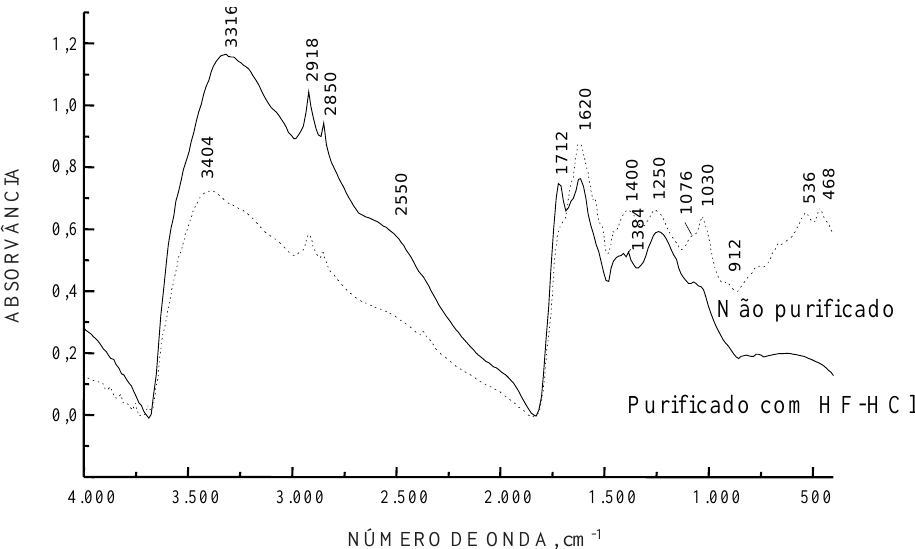
Figura 4. Espectros de absorvância no infravermelho dos ácidos húmicos purificados e não purificados, extraídos do horizonte Bhs de um